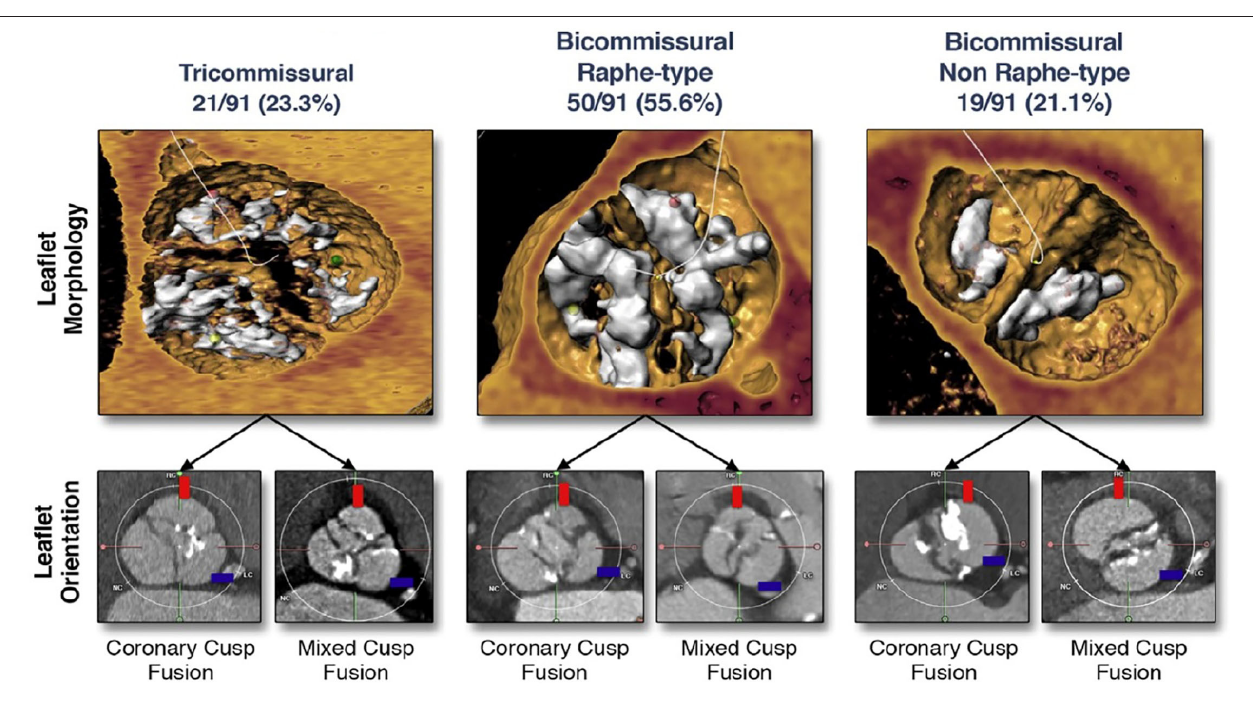
FIGURE 2 | Bicuspid aortic valve classification in the TAVI era